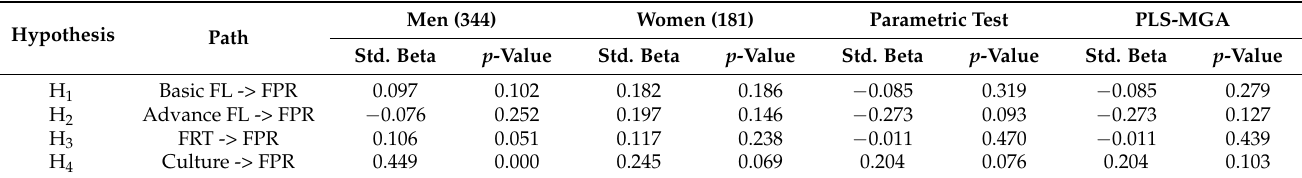
Table 8. Results of